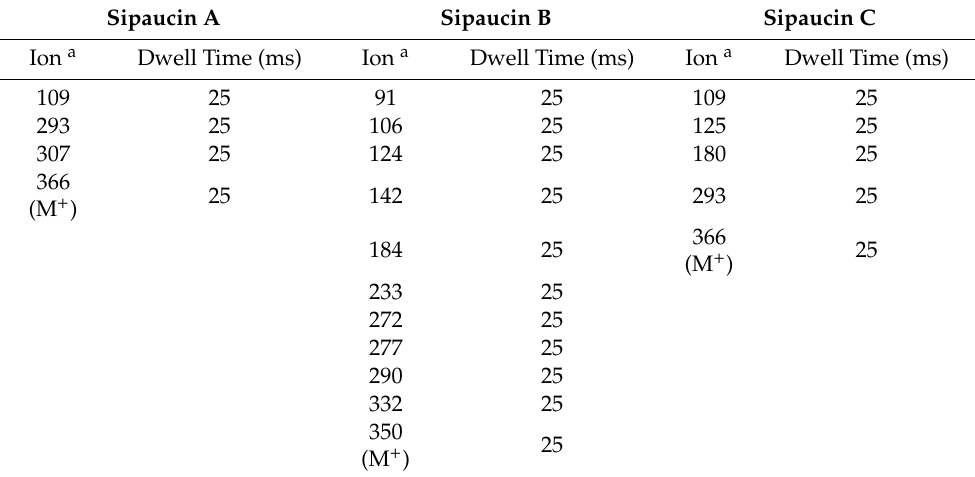
Table 3. SIM / MS method for the detection of Sipaucins in the